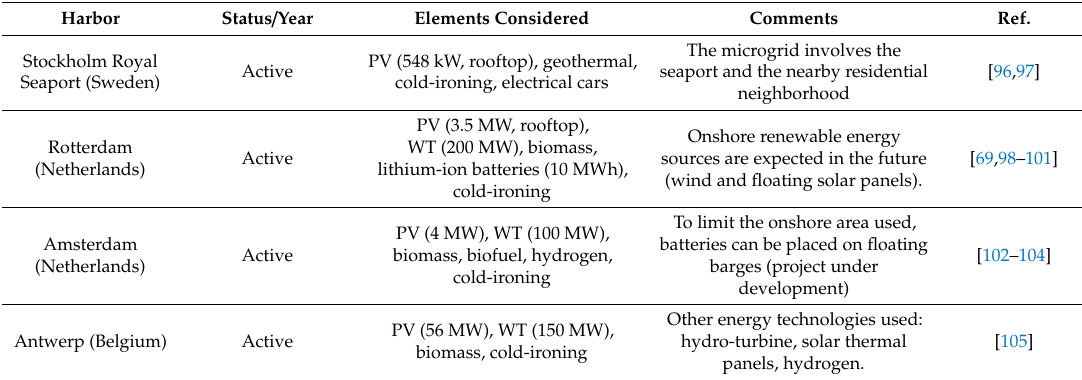
Table 4. Examples of microgrid implementation in harbor